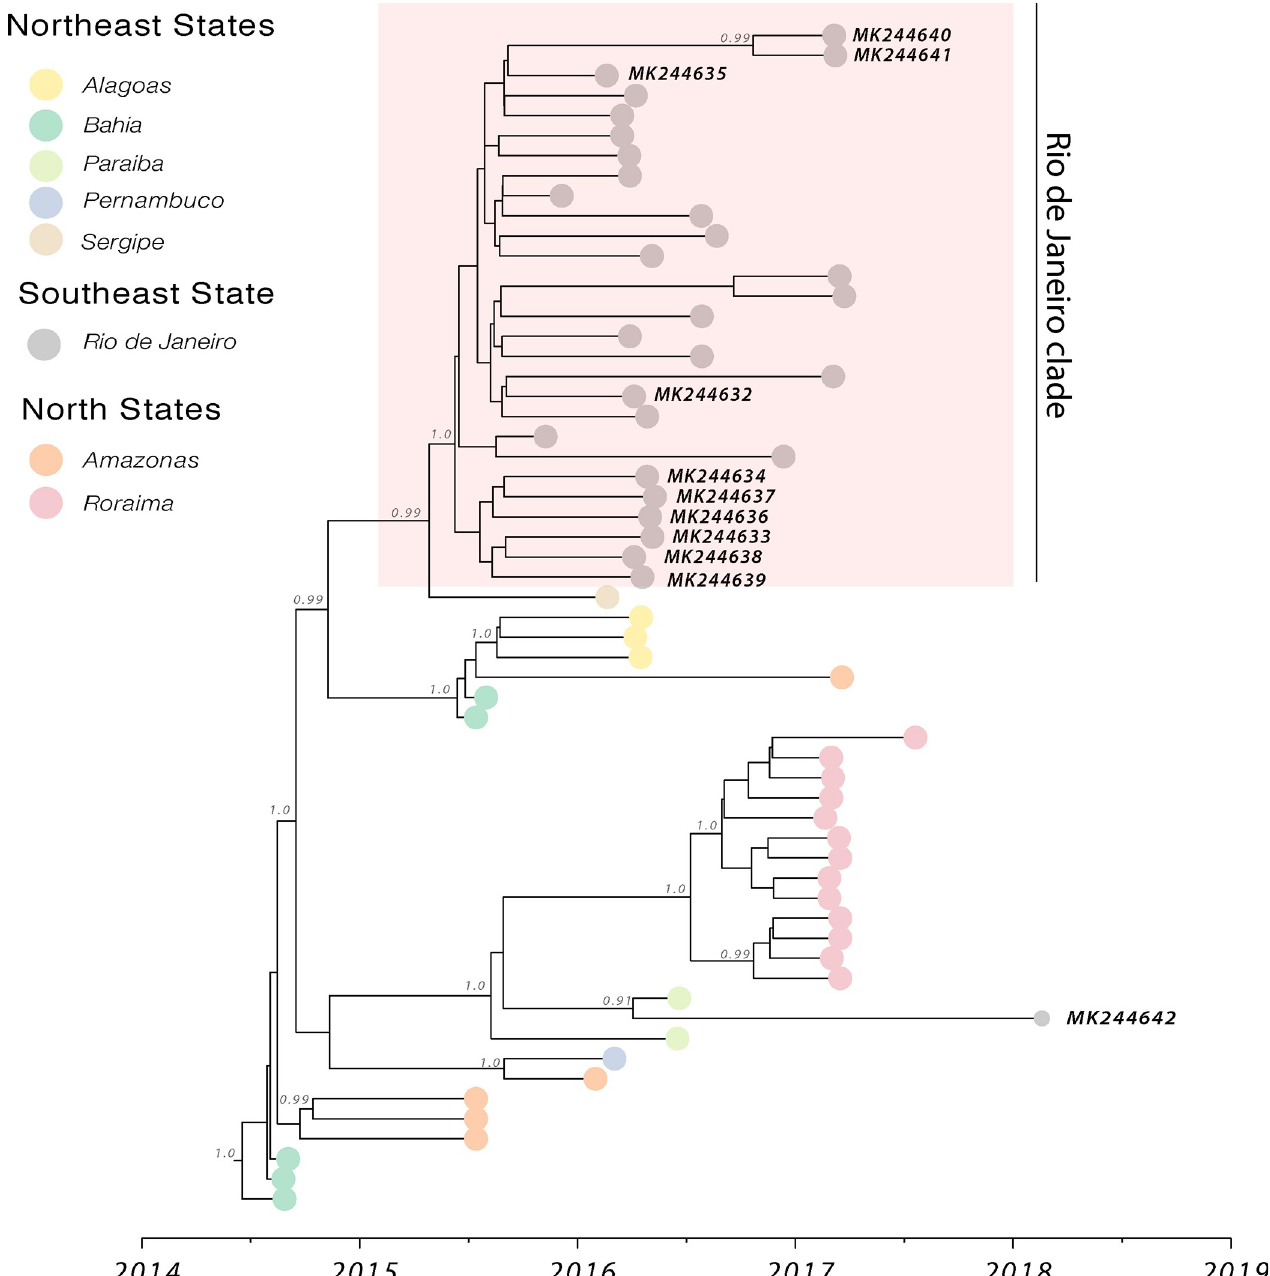
Fig 1. Molecular clock phylogeny of the CHIKV circulating in Rio de Janeiro state. Molecular clock phylogeny obtained using 11 new CHIKV near- complete genomic sequences from the 2016–2018 epidemic in Rio de Janeiro, including 48 publicly available Brazilian CHIKV-ECSA lineage sequences. Numbers along branches represent clade posterior probability > 0.90. Colours represent different